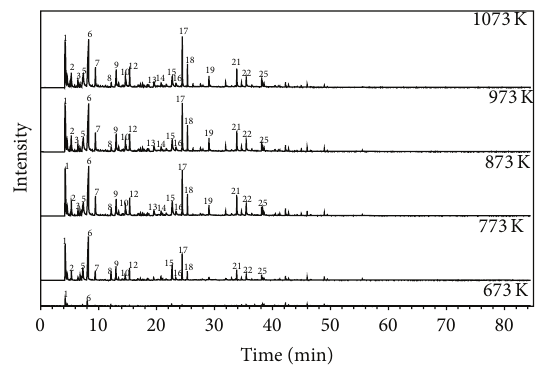
Figure 4: Chromatograms of pyrolysis of coconut shells at different